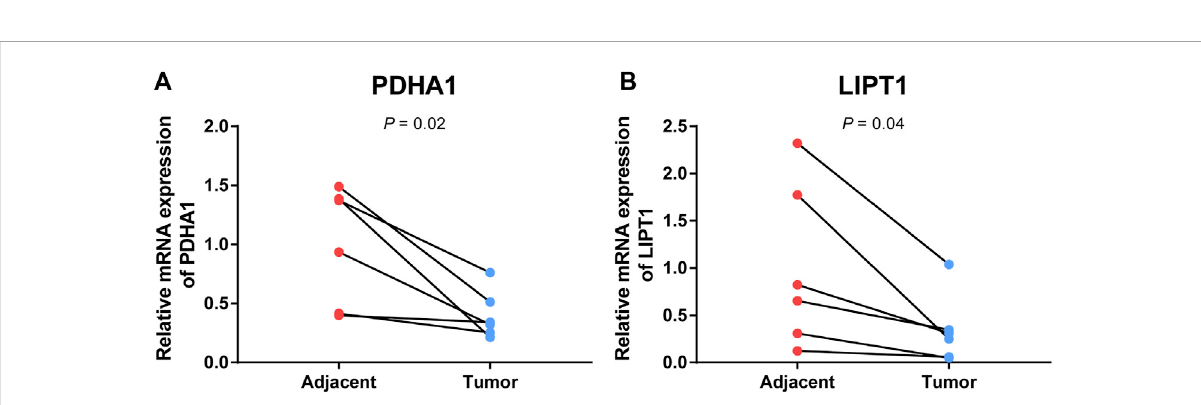
FIGURE 11 Validation of mRNA expression levels of cuproptosis-related genes in paired tumor tissues. mRNA levels of PDH1 (A) and LIPT1 (B) in paired tumor tissues were measured by